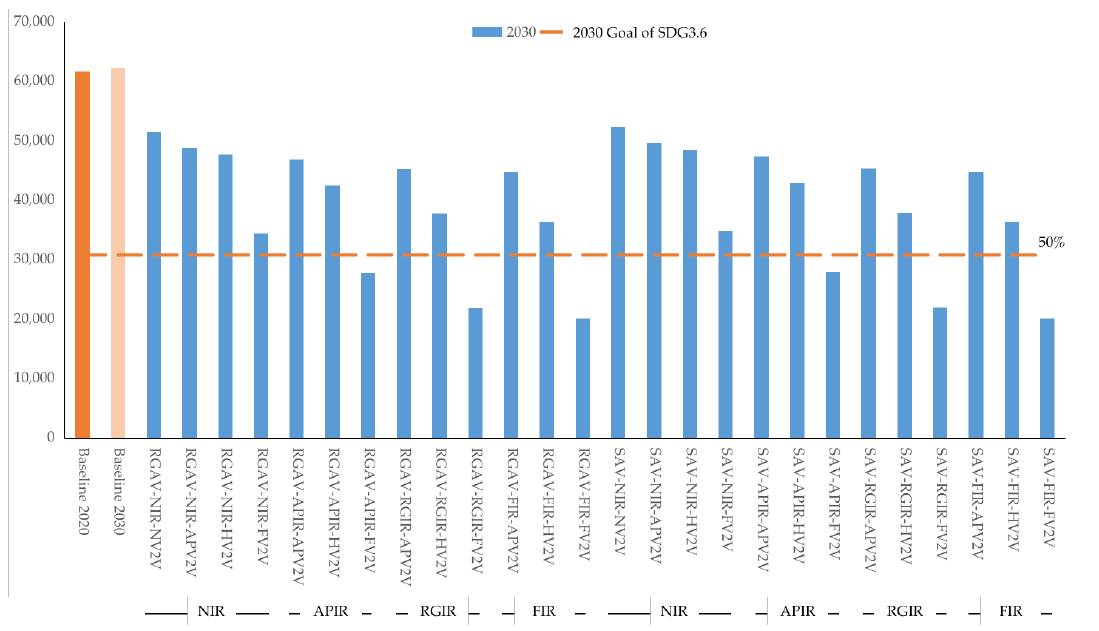
Figure 4. Estimated annual road fatalities in 26 scenarios in 2030 in China.